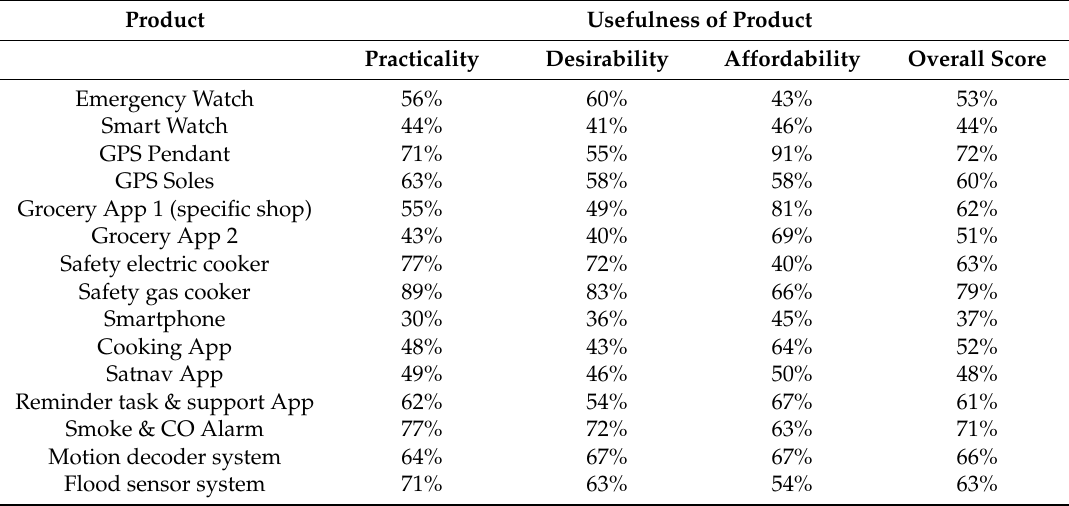
Table 3. Carer assessment (scores out of 100%) of the 15 technology products ( n =